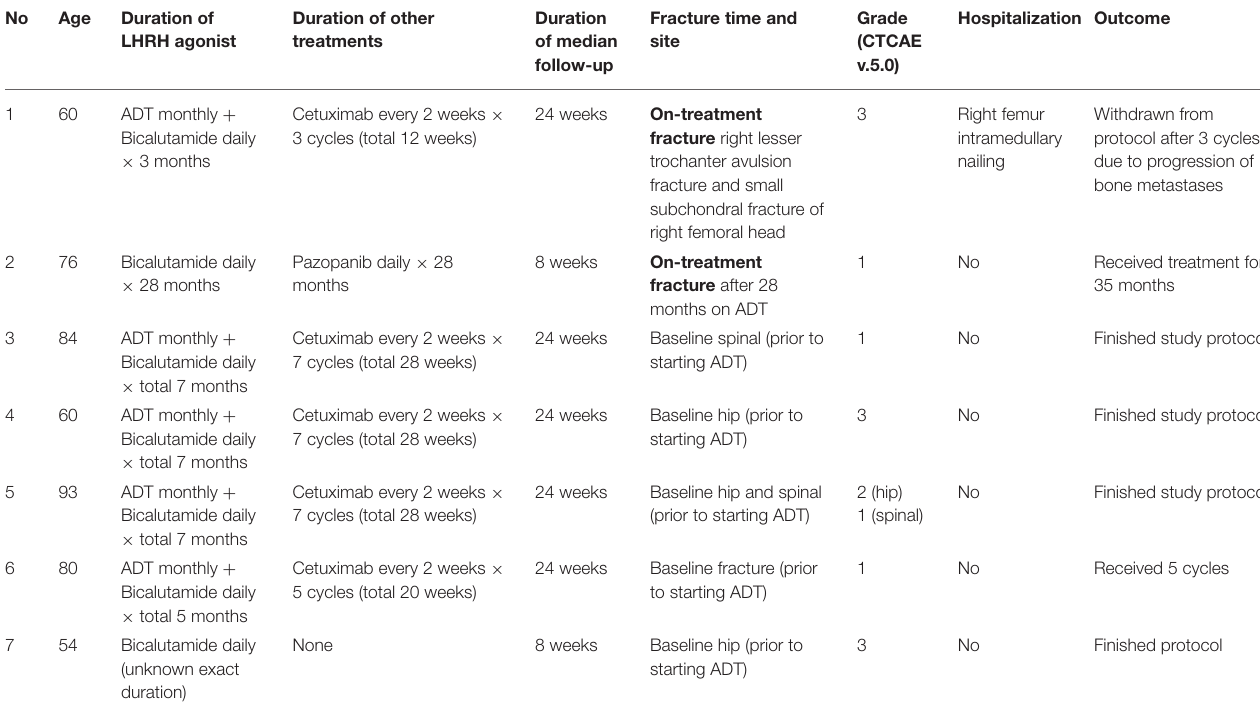
TABLE 4 | Subject case descriptions for those with bone